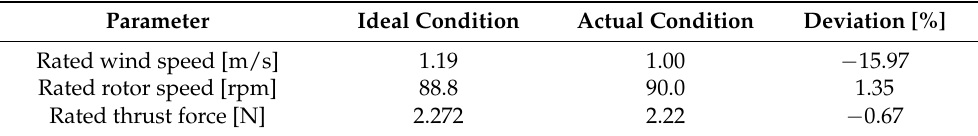
Table 5. Load cases for model test and numerical simulation.